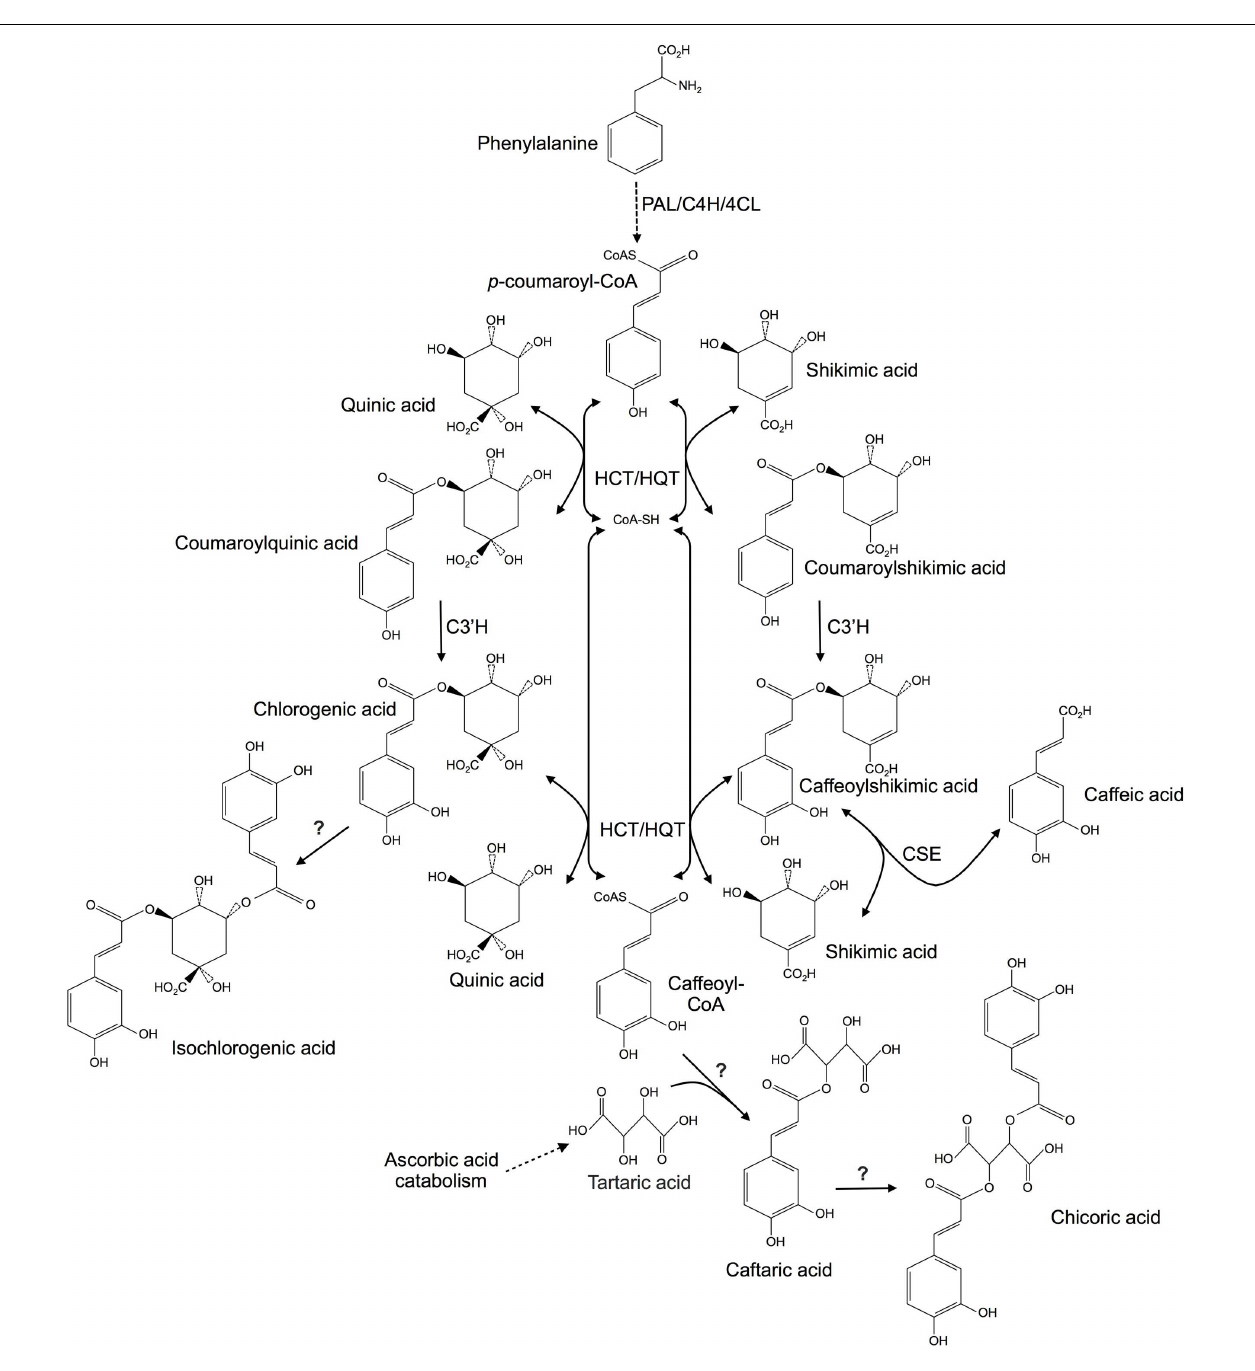
FIGURE 1 | Putative metabolic pathways involved in hydroxycinnamic acid biosyntheses in plants. Question marks indicate enzymes that have been characterized biochemically but which are not supported by molecular data. PAL, phenylalanine ammonia lyase; C4H, cinnamate 4-hydroxylase; 4CL, 4-coumaroyl CoA ligase; HCT, hydroxycinnamoyl-CoA:shikimate/quinate hydroxycinnamoyltransferase; HQT, hydroxycinnamoyl-CoA:quinate hydroxycinnamoyltransferase; C3 (cid:48) H, p -coumaroyl ester 3 (cid:48) -hydroxylase; CSE, caffeoyl shikimate esterase.